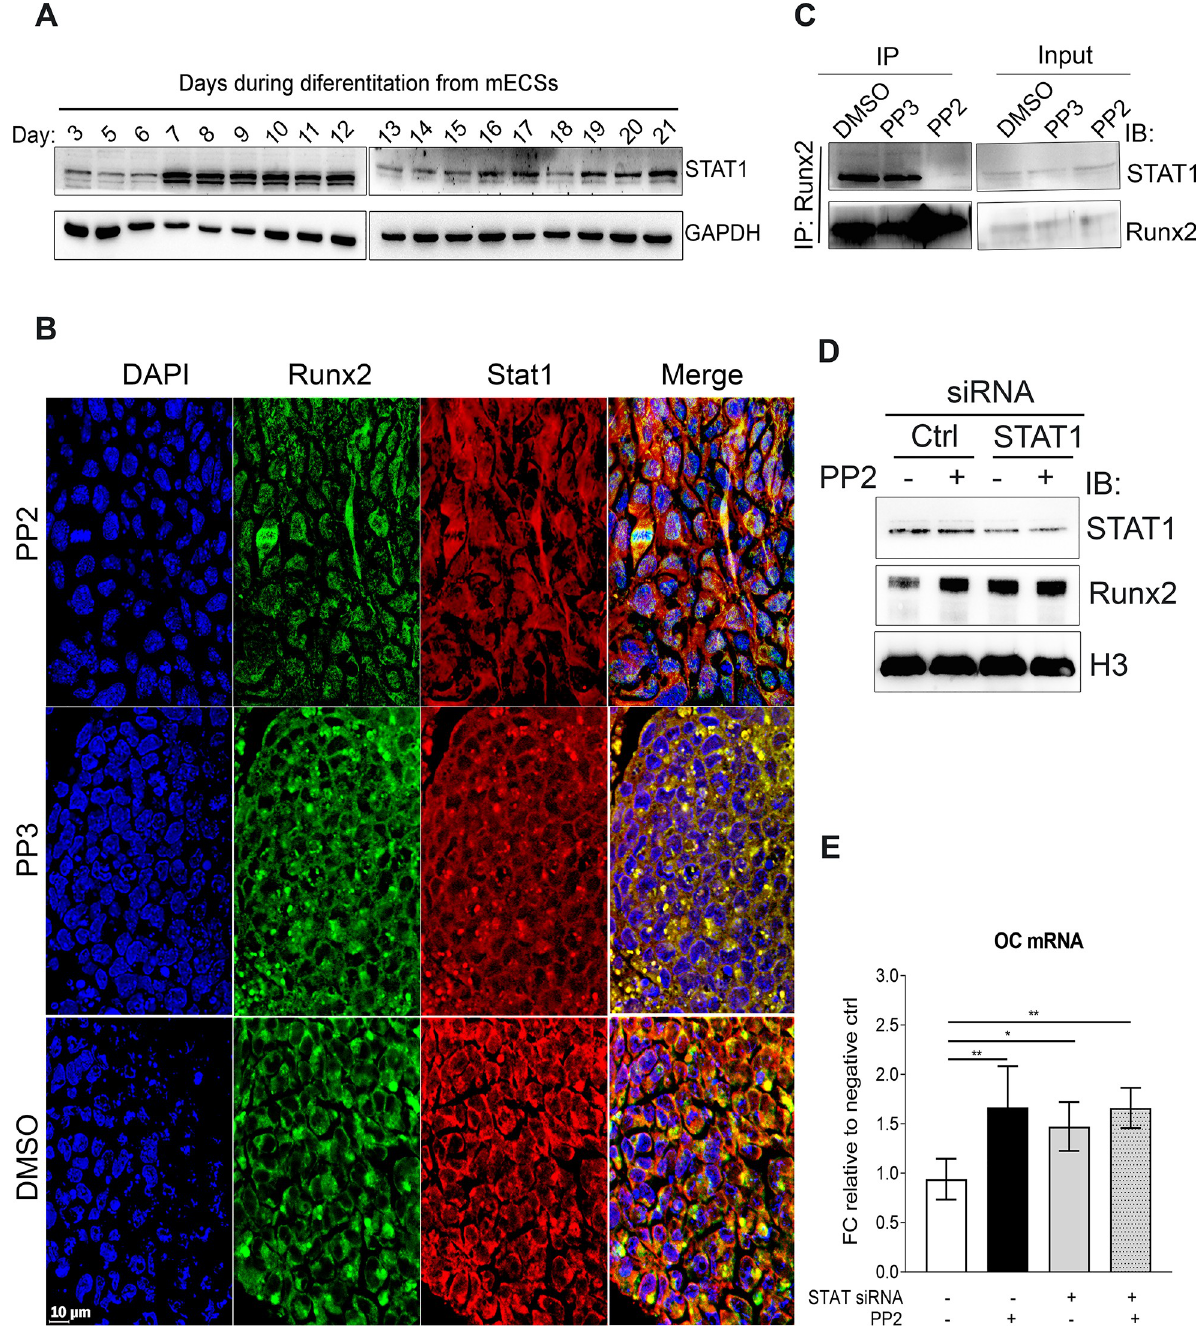
Fig 3. c-Src regulates Runx2 subcellular localization through STAT1. (A) STAT1 expression throughout osteogenic differentiation from mESCs. Differentiating EBs from day 3 to 21 have been subjected to WB analysis using STAT1 antibody. GAPDH served as loading control. (B) Subcellular localization of Runx2 and STAT1 in the presence and absence of c-Src activity. D15 differentiating EBs underwent treatment with DMSO, PP3, and PP2 for two hours and were fixed and subjected to IF staining using Runx2 (green) and STAT1 (red) antibodies. DAPI was used to stain nuclei (blue). (C) Runx2 interaction with STAT1 in the presence or absence of c-Src activity. Differentiating EBs were treated with PP2 (10 μ M) or PP3 (10 μ M) or DMSO as controls for 2 hrs. Cell lysates were then subjected to IP assays and analyzed by immunoblot. (D) c-Src effect on Runx2 in STAT1 depleted MC3T3-E1. Cells were transfected with STAT1 specific siRNA along with Silencer ™ select negative control siRNA. 48 hours post transfection cells were treated either with PP2 (10 μ M) or DMSO for 2 hours prior to fractionation assay. Nuclear fractions were analyzed by WB analysis. H3 and GAPDH served as loading controls. (E) Real-time analysis OC expression in response to c-Src inhibition by PP2 in STAT1 depleted cells. MC3T3-E1s were transfected with control siRNA or validated siRNAs targeting STAT1 for 48 hrs and treated with either PP2 (10 μ M) or DMSO as controls for 24